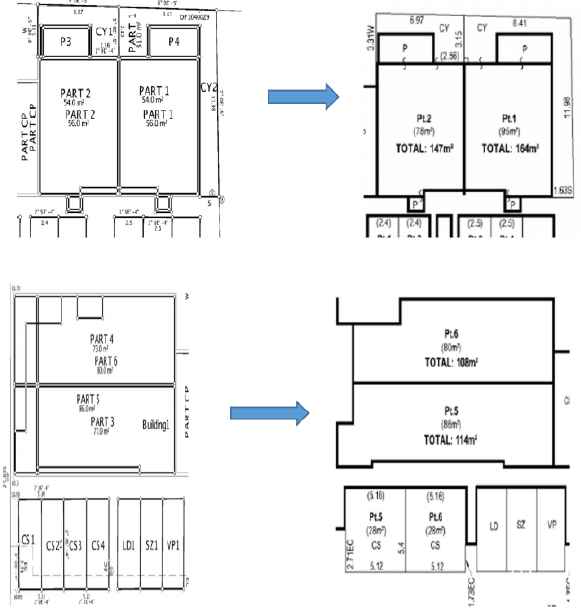
Figure 9 : Land XML Rendering and TIFF